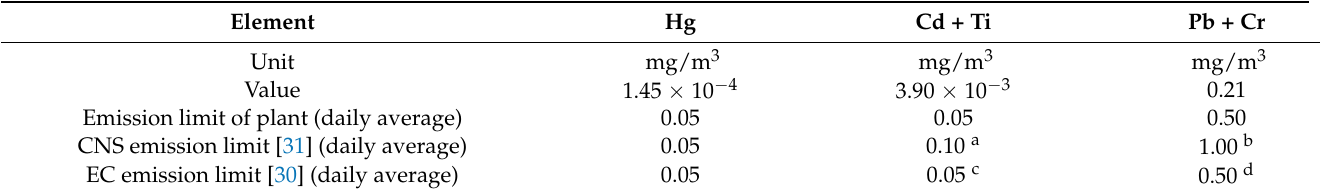
Table 5. The emission concentrations of heavy metals in the flue gas.